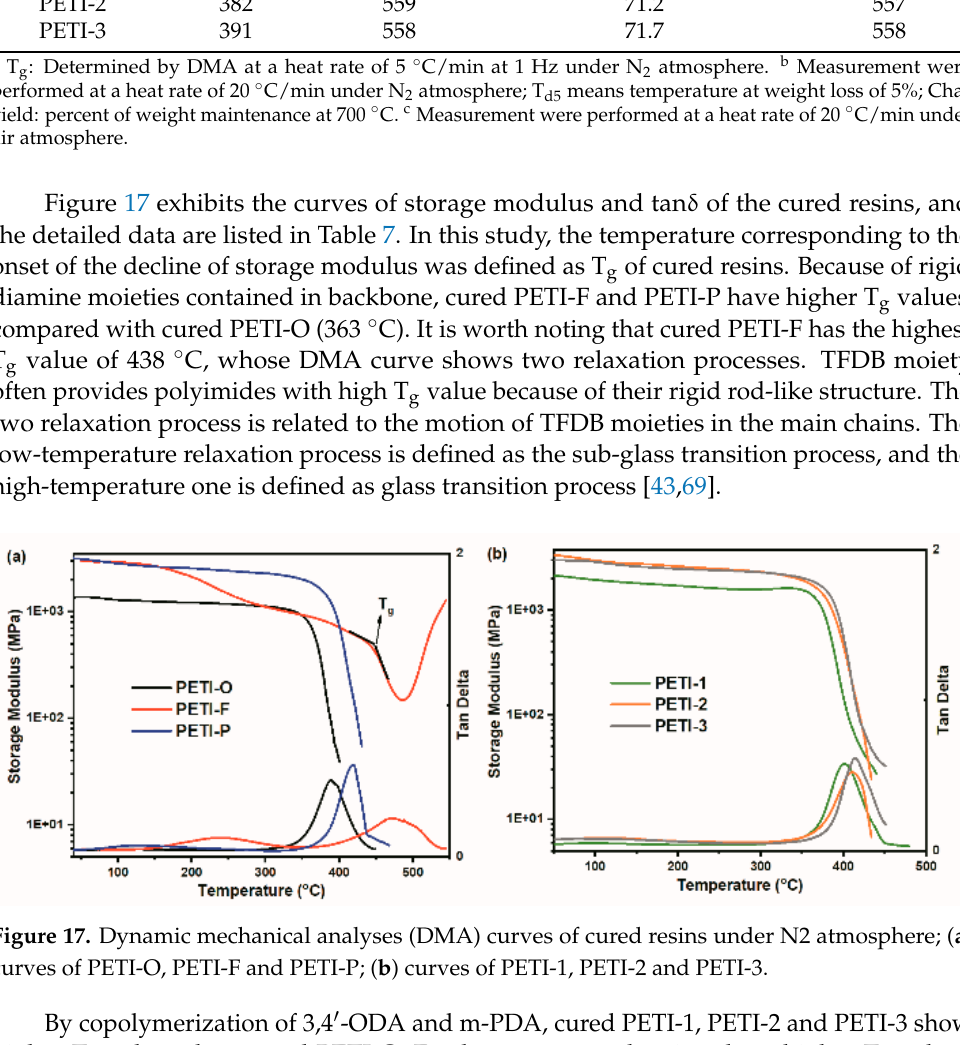
Figure 17. Dynamic mechanical analyses (DMA) curves of cured resins under N2 atmosphere; ( a ) curves of PETI-O, PETI-F and PETI-P; ( b ) curves of PETI-1, PETI-2 and PETI-3 Table 7. Thermal properties of the thermal-cured polyimides cured at 380 °C for 2 h.